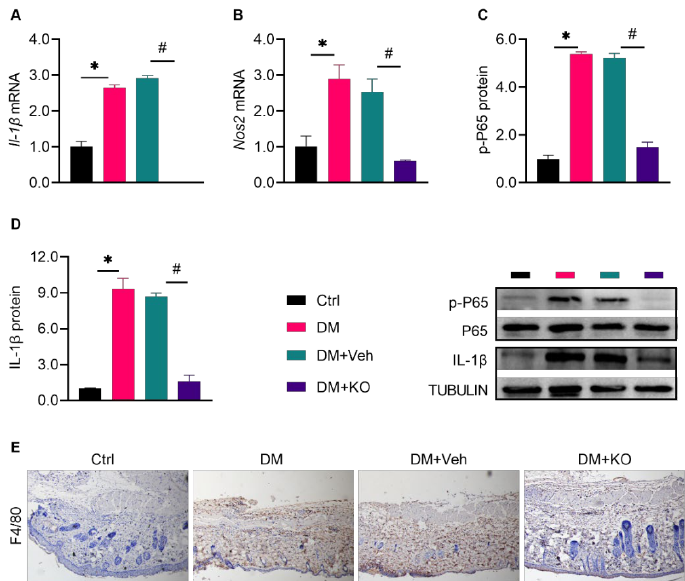
Figure 3. KO attenuated the DM-induced cutaneous inflammation. Seven days post skin excision, the ( A ) Il-1 β mRNA levels, ( B ) Nos2 mRNA levels, ( C ) protein ratio of p -P65 to P65, ( D ) IL-1 β protein levels were determined, and ( E ) IHC staining was performed to detect the expression of the macrophage marker F4/80 in the wound tissue. For ( A – D ), the data were normalized to Ctrl, and summarized as means ± SD. *, p < 0.05 vs. Ctrl; #, p < 0.05 vs. DM. IHC, immunohistochemical; Il-1 β , interleukin 1 beta; Nos2 , nitric oxide synthase 2. The other abbreviations are the same as in Figure 1.